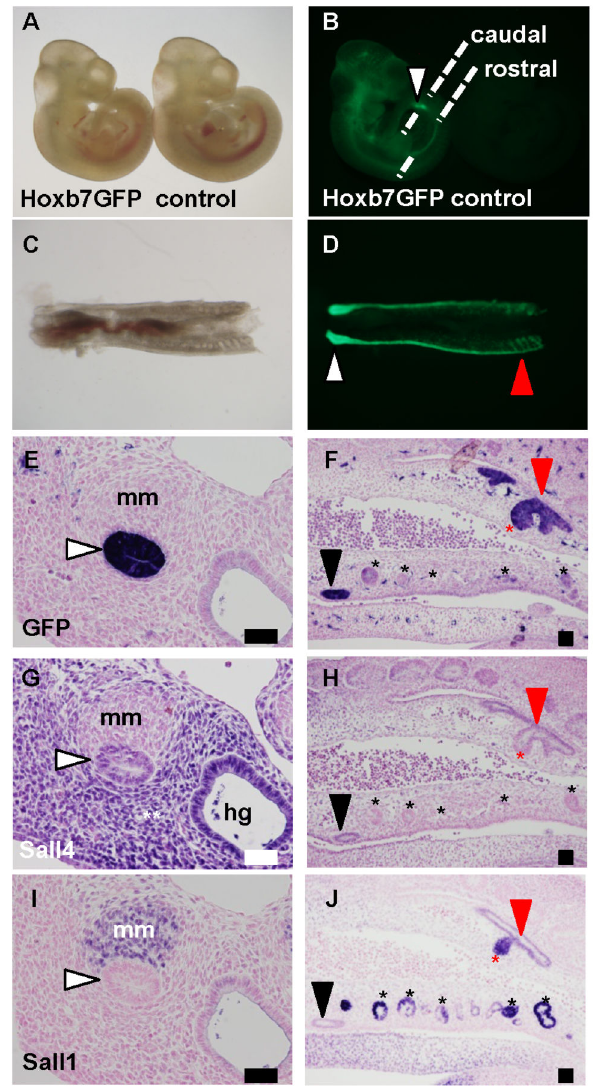
Figure 2. Sall4 is expressed in the caudal Wolffian duct at E10.5. (A, B) Bright-field and fluorescence views of Hoxb7GFP and control mice at E10.5. The dotted lines indicate the planes used for the caudal and rostral sections. (C, D) Bright-field and fluorescence views of the nephric region of a Hoxb7GFP mouse. (E, F) Green fluorescent protein staining of caudal and rostral sections from a Hoxb7GFP mouse. The right side of panel F is the rostral side. (G, H) Sall4 staining of the neighboring sections. (I, J) Sall1 staining of the neighboring sections. White arrowhead: caudal end of the Wolffian duct; black arrowhead: middle part of the Wolffian duct; red arrowhead: rostral part of the Wolffian duct; white double asterisk: tissues surrounding kidney primordia and hindgut; black asterisk: mesonephric tubule; red asterisk: rostral mesonephric tubule; hg: hindgut; mm: metanephric mesenchyme. Scale bars: 50 µm. doi: